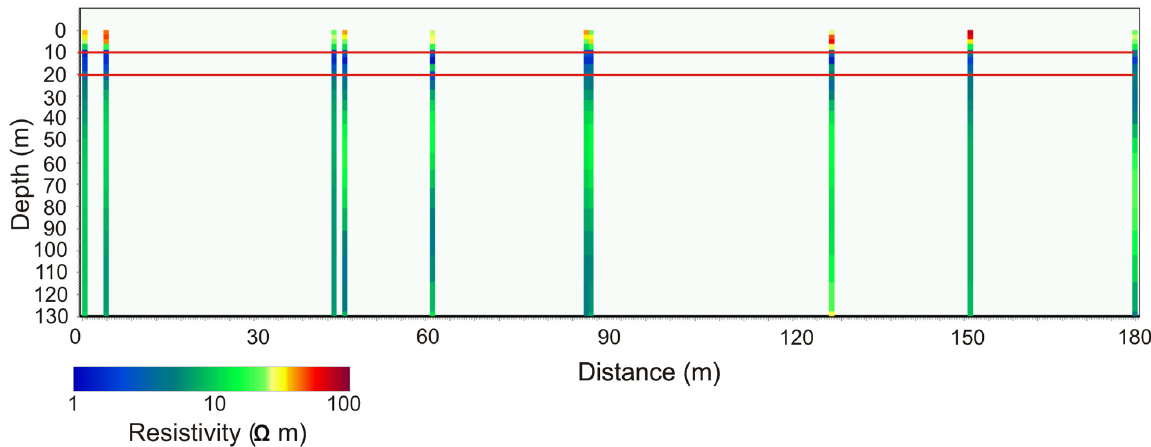
Figure 5. WSW–ENE resistivity section as illustrated in Figure 1b. Smooth inversion results calculated for each soundings are plotted in the profile section. Top and bottom red lines highlight a 10 m thick clay layer throughout the